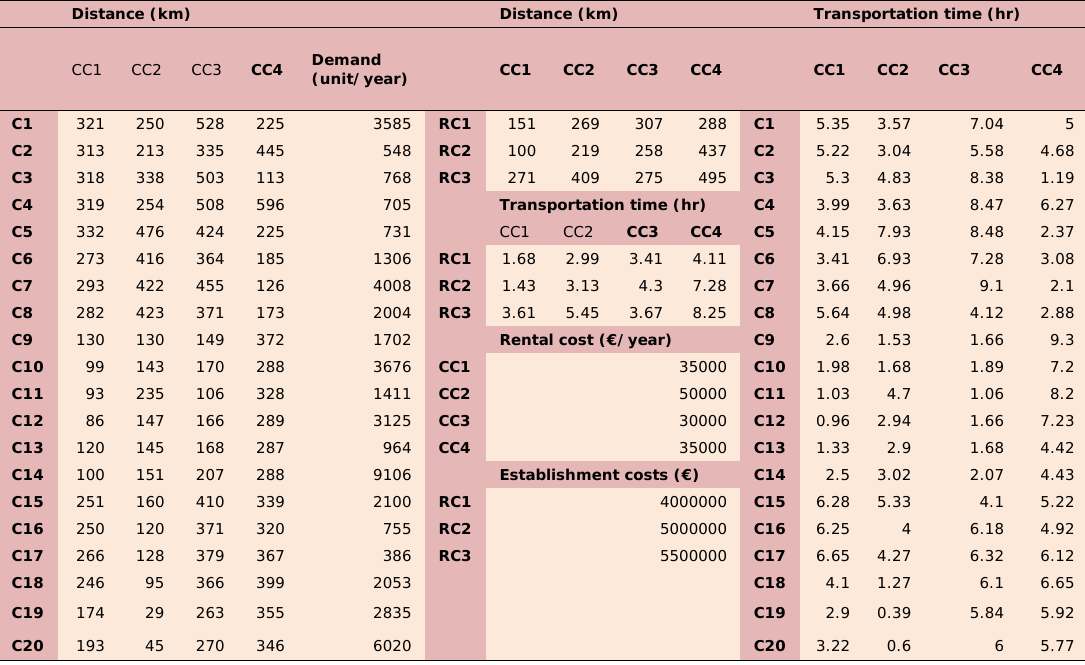
Table 2. Input data for the high-tech after sale services network design